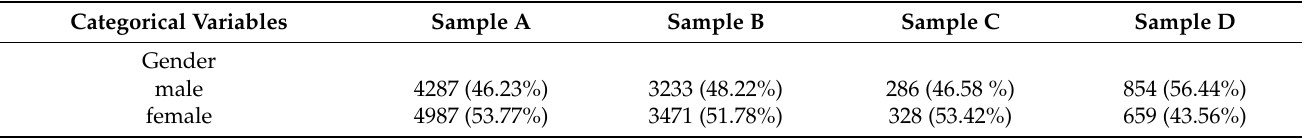
Table 1. Descriptive